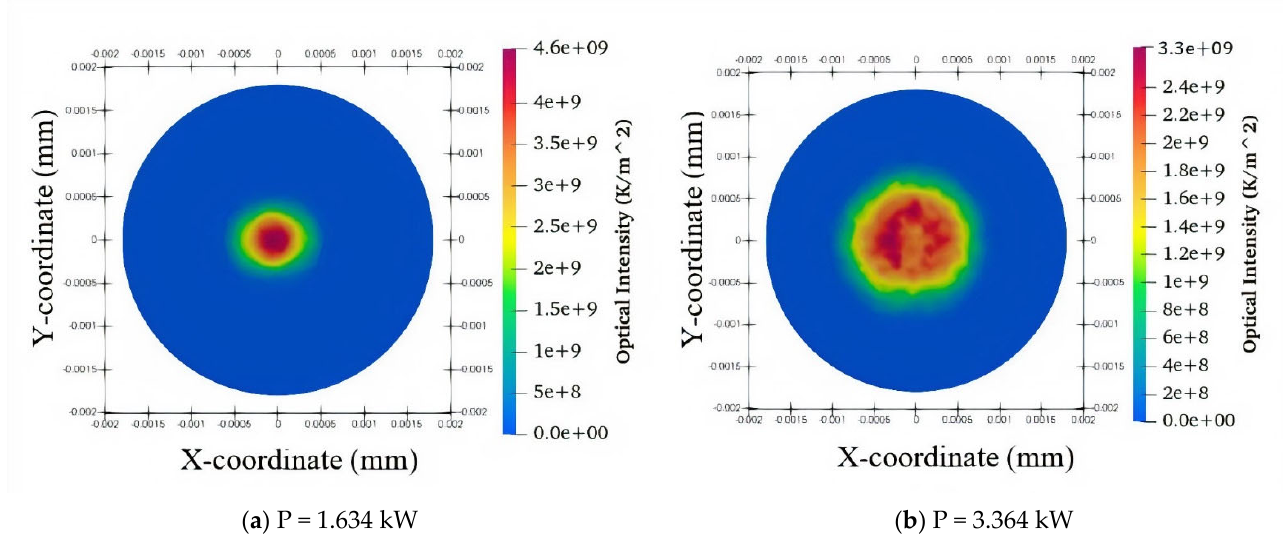
Figure 10. Power density distributions ( a ) 1.634 kW and ( b ) 3.364 kW in the focal plane position of F z = 0.1mm.